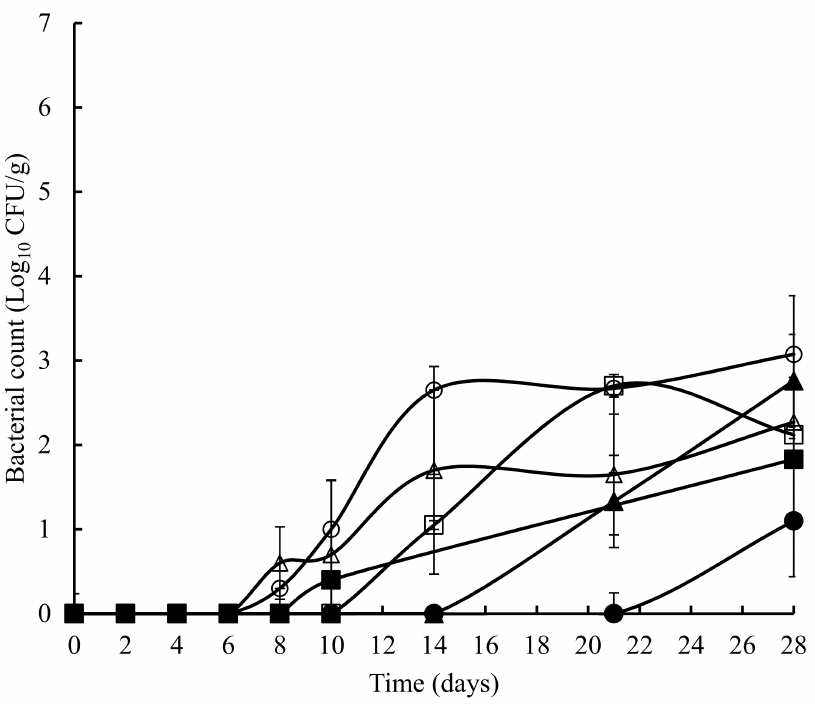
Figure 4. Hydrogen disulphide (H2S) producing bacteria in crab meat samples stored at 4 ◦ C with the following treatments: SDW ( (cid:4) ), Ascorbic Acid ( ), Casein ( (cid:78) ), Casein and Ascorbic Acid ( (cid:3) ), Potato Starch (o), and Potato Starch and Ascorbic Acid ( ∆ ). The error bars represent 1 standard